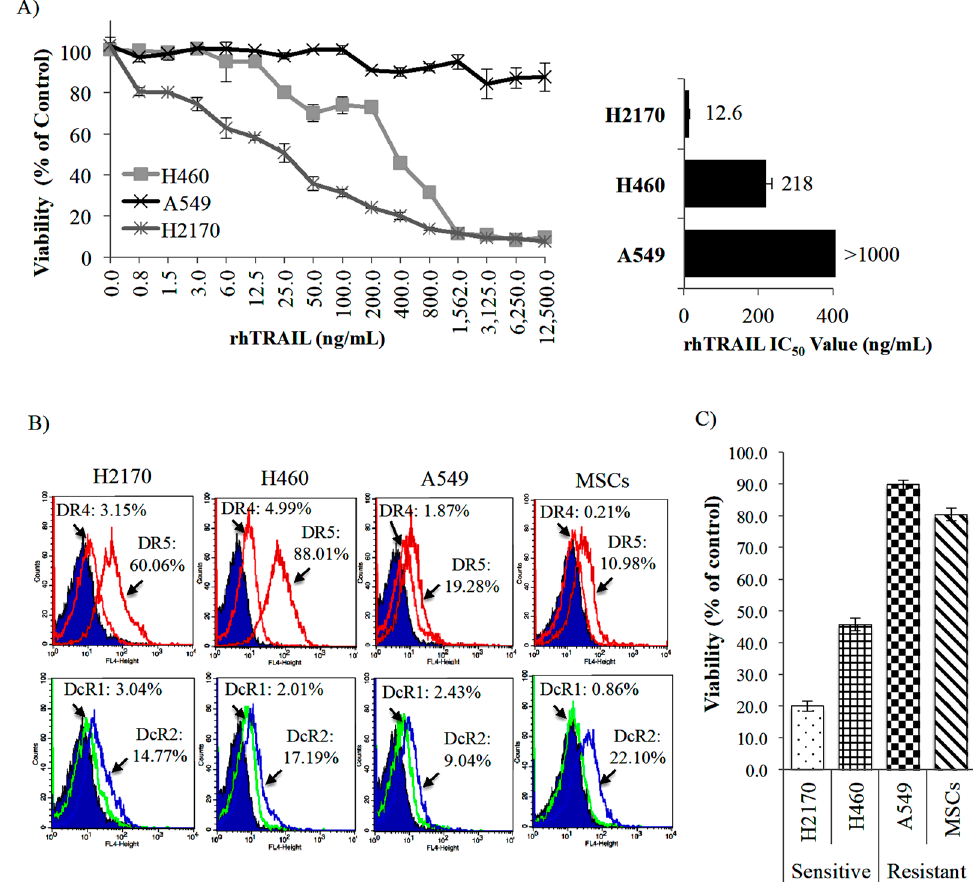
Figure 2. TRAIL sensitivity by in vitro characterization. ( A ) The half maximal inhibitory concentration (IC 50 ) value was determined in non-small cell lung cancer (NSCLC) cell lines (H460, H2170 and A549) by MTS assay after 48 h of rhTRAIL treatment at different concentrations. ( B ) Analysis of TRAIL receptors expression [agonist receptors (DR4 and DR5) and decoy receptors (DcR1 and DcR2)] in MSCs and NSCLC cell lines by flow cytometry. ( C ) Sensitivity of NSCLC cell lines and MSCs evaluated by MTS assay after rhTRAIL (500 ng/mL) treatment.